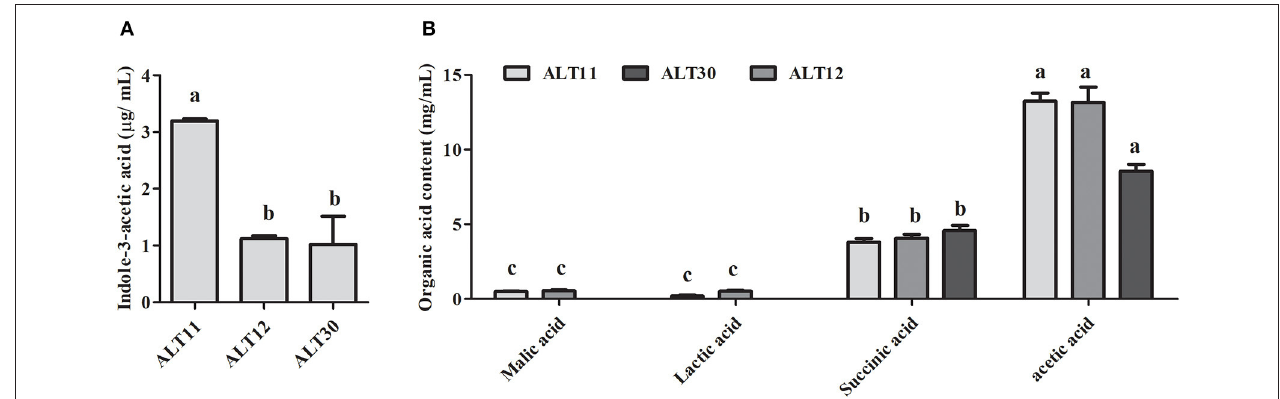
FIGURE 1 | Quantification of indole-3-acetic acid (IAA) and organic acids produced by isolates ALT11, ALT12, and ALT30. (A) GC/MS-SIM analysis of the IAA content in the culture broth of isolate ALT1, (B) organic acid detection and quantification using high-performance liquid chromatography relative to their respective standard. Different letters indicate significant differences between the mean values of three replicates ± standard